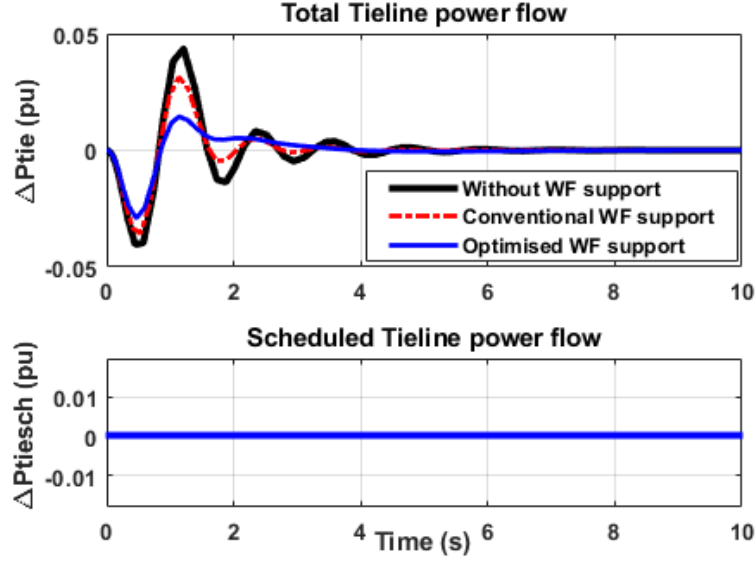
Figure 13. Tie line power flow in a Poolco